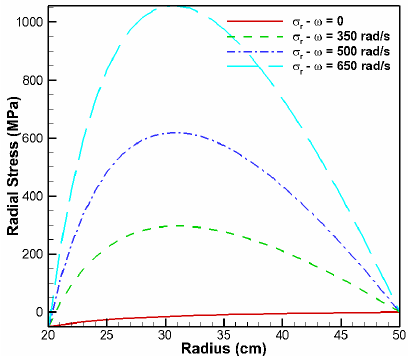
tangential stresses